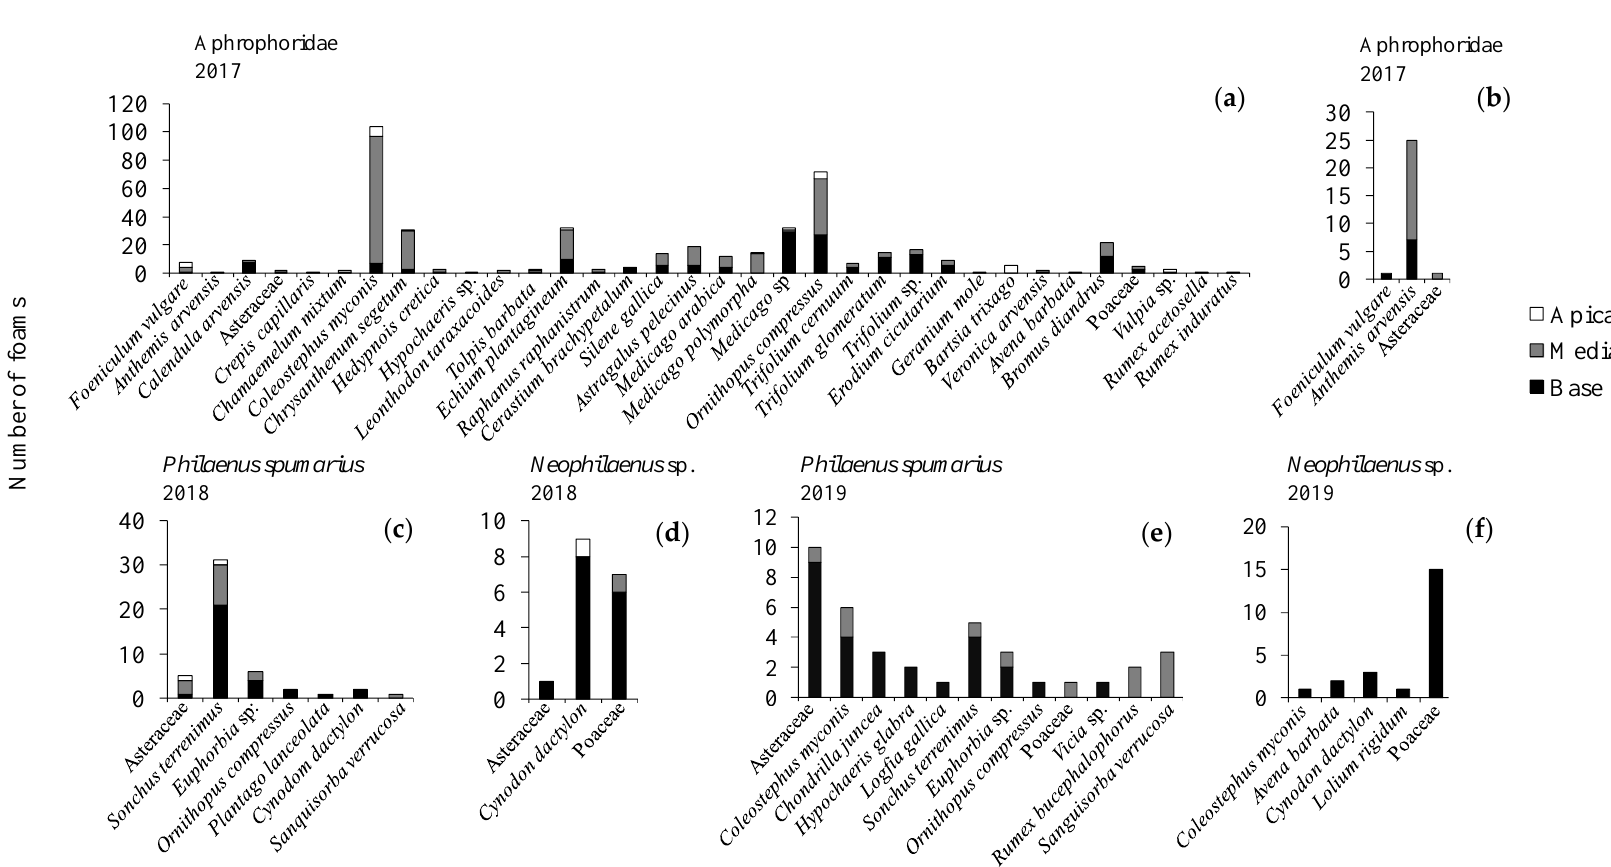
Figure 7. Number of given nymphal foams in the apical, middle, or base part of the host plant in: ( a ) an abandoned olive grove (UNP)—Aphrophoridae, 2017; ( b ) an integrated olive grove (P)—Aphrophoridae, 2017; ( c ) P— Philaenus spumarius , 2018; ( d ) P— Neophilaenus sp., 2018; ( e ) P— P. spumarius , 2019; ( f ) P— Neophilaenus sp., 2019.